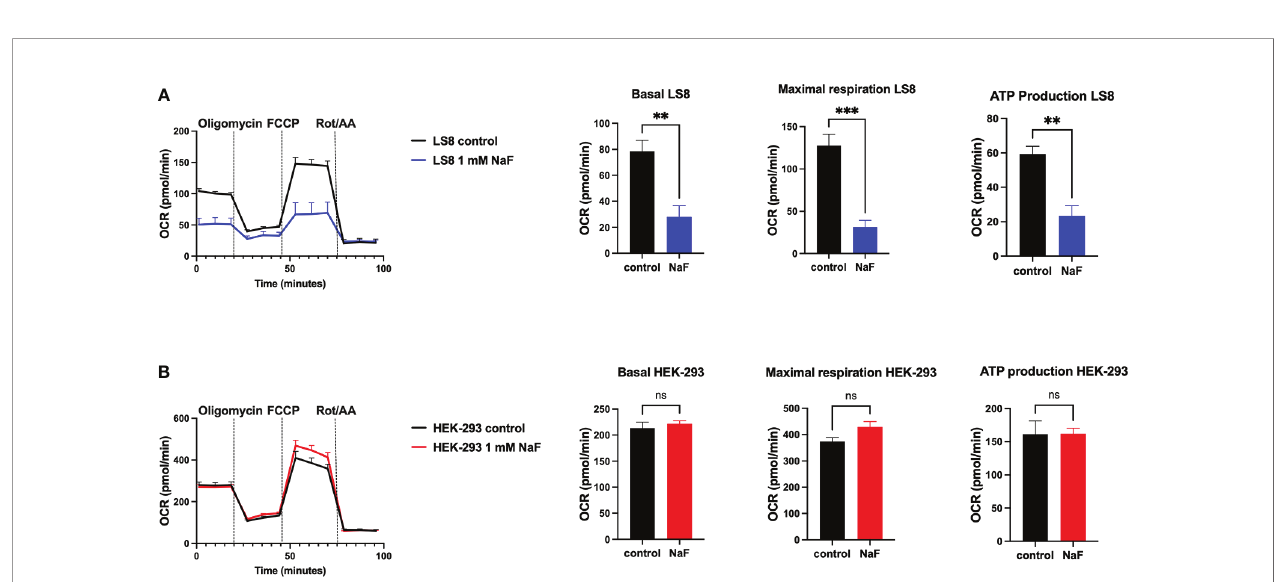
FIGURE 2 | Mitochondrial OCR in fl uoride treated cells. Oxygen consumption rate (OCR), basal respiration, ATP production and maximal respiration in LS8 cells (A) and in HEK-293 cells (B) after 4 hours of NaF (1 mM) pre-treatment. Oligomycin (1 µM), FCCP (1.5 µM) and rotenone/antimycin A (Rot/AA - 0.5 µM) were serially added in a Seahorse XFe24 Analyzer to assess differences in oxidative phosphorylation. Fluoride treatment affects OCR in the enamel LS8 cells but not HEK-293 cells (ns, not signi fi cant). Data represent the mean ± SEM of 3 independent experiments using unpaired Student ’ s t test. (** p < 0.01, *** p <